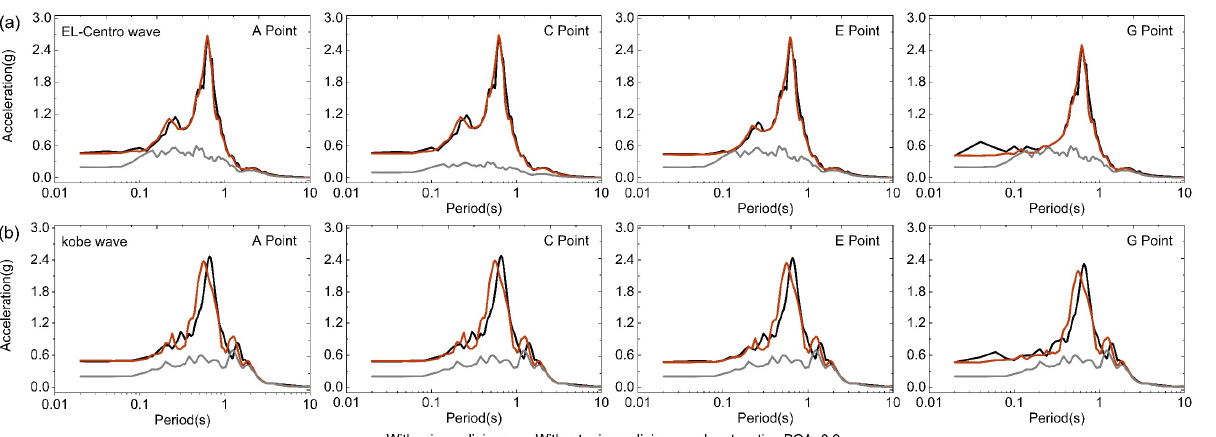
Figure 12. Horizontal acceleration amplification along the tunnel.